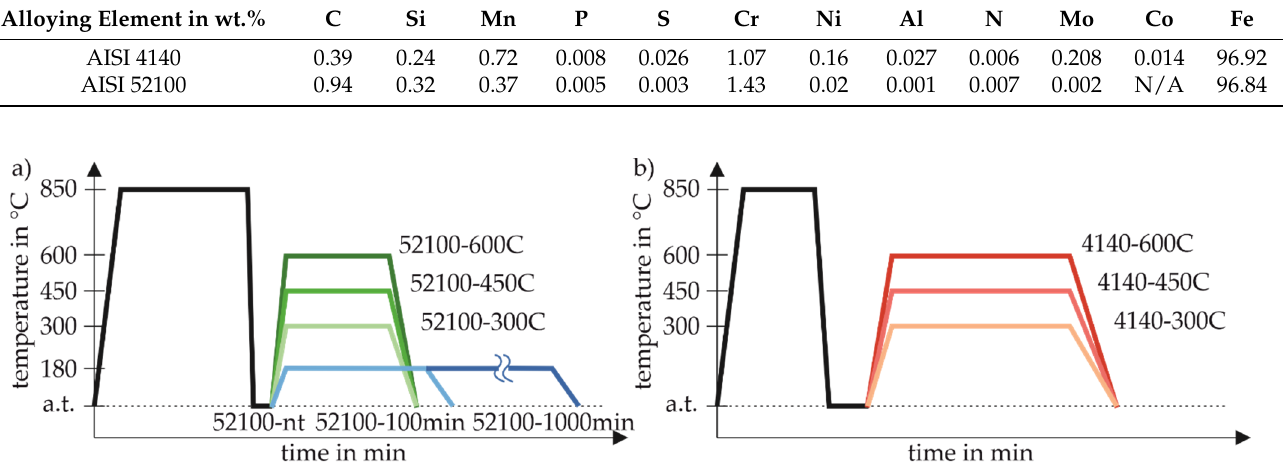
Table 1. Chemical composition of the investiagted batches.